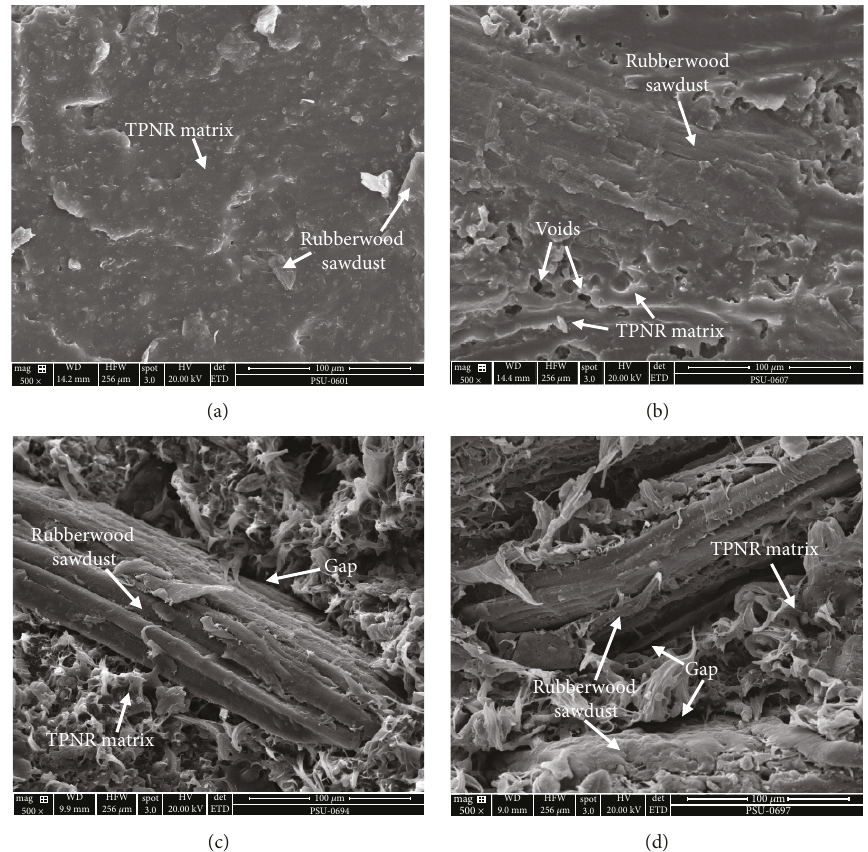
Figure 4: SEM images of R60/P40 composites with (a) 30 wt% RWS and (b) 60 wt% RWS and R30/P70 composites with (c) 30wt% RWS and (d) 60 wt% RWS. All formulations reinforced with RWS 40